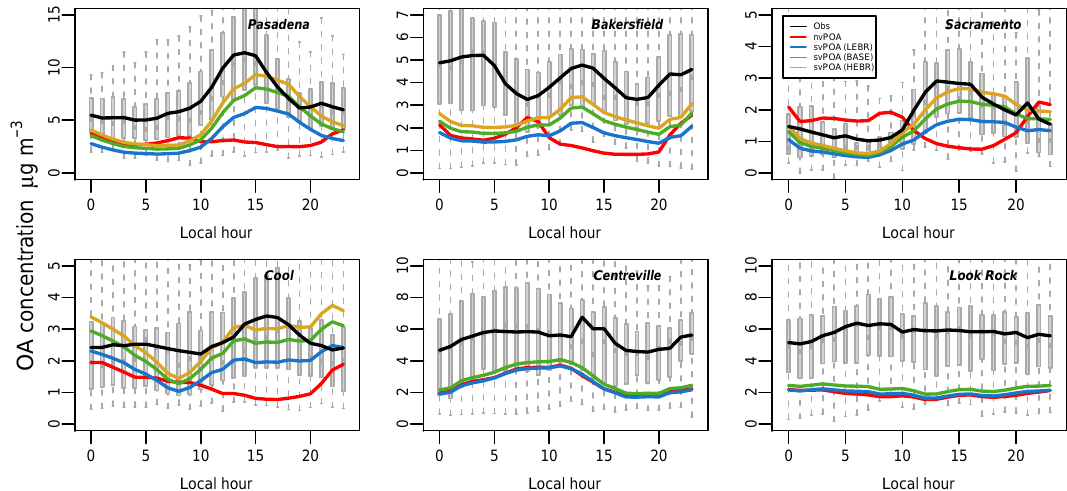
Figure 5. Diurnal OA concentration profile (µgm − 3 ) observed (black line, gray bars) with the HR-ToF-AMS at sites investigated during the CalNex, CARES, and SOAS campaigns. Also shown are the model-predicted distributions for the nvPOA case, the BASE case, and two sensitivity cases (LEBR and HEBR). The boxes behind each trend indicate the 25th and 75th percentiles of the data. The whiskers extend to the 10th and 90th percentiles. The solid horizontal lines in each box identify the median, and the solid curves indicate the means of each model run. Model values are projected to PM 1 to correspond roughly to the size cutoff of the AMS.